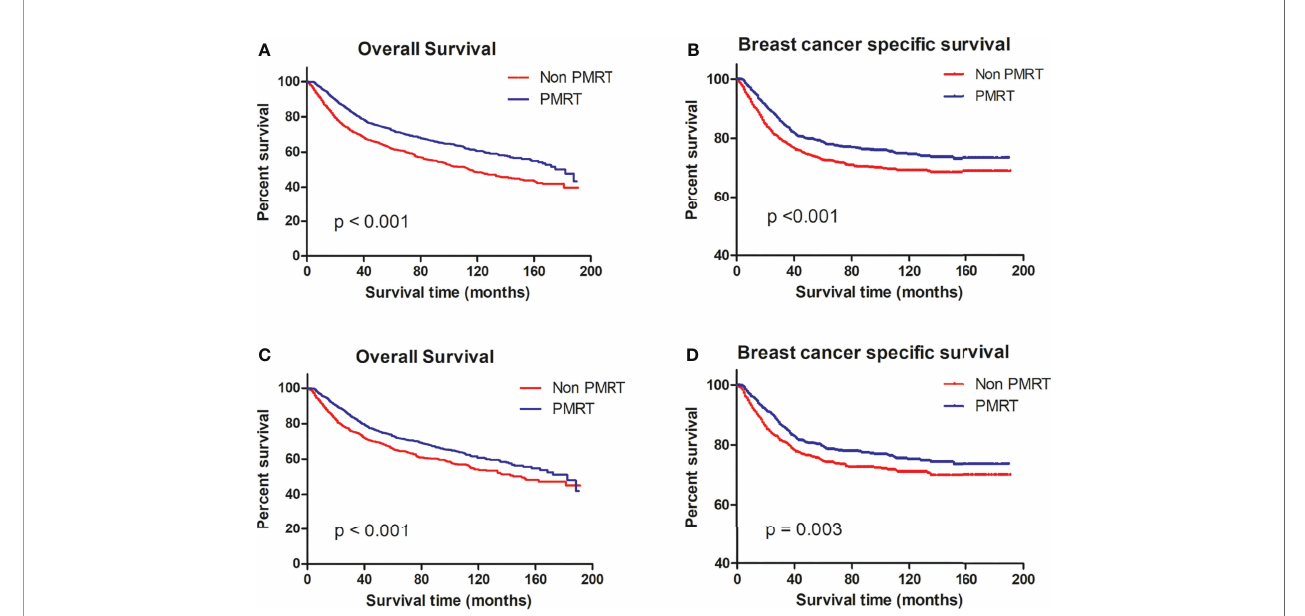
FIGURE 2 | OS and BCSS of MBC patients displayed as Kaplan – Meier curve strati fi ed according to PMRT. (A) OS curve of the non-PMRT group versus PMRT group before PSM; (B) BCSS curves of the non-PMRT group versus PMRT group before PSM; (C) OS curve of the non-PMRT group versus PMRT group after PSM; (D) BCSS curves of the non-PMRT group versus PMRT group after PSM. MBC, metaplastic breast cancer; OS, overall survival; BCSS, breast cancer-special survival; PMRT, post mastectomy radiotherapy; PSM, propensity score